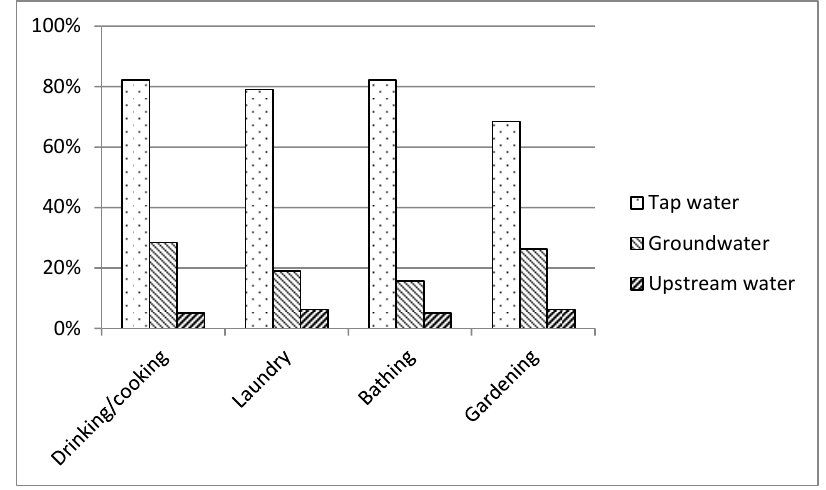
Figure 3. Water use before the 2011 tsunami. Note: the respondents were allowed to choose multiple uses.